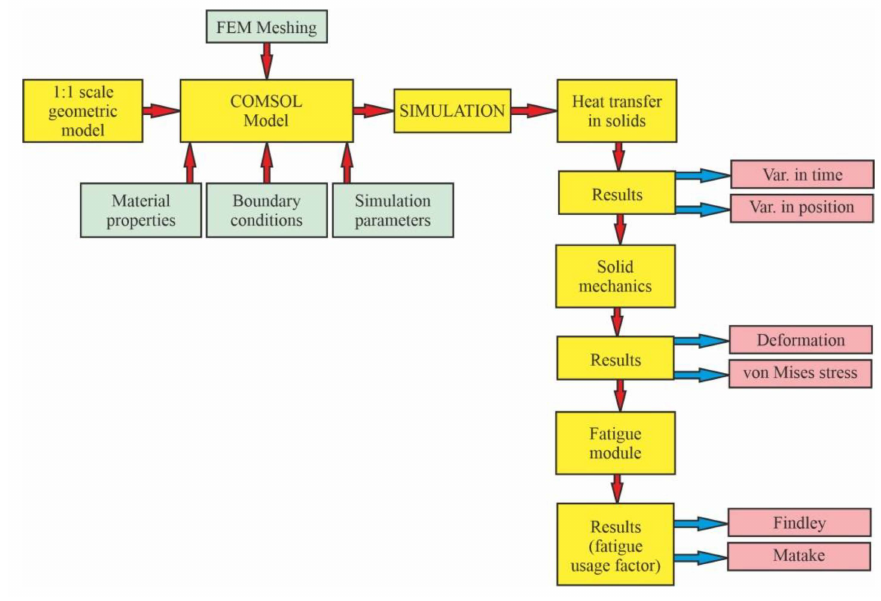
Figure 3. The step by step approach used in the